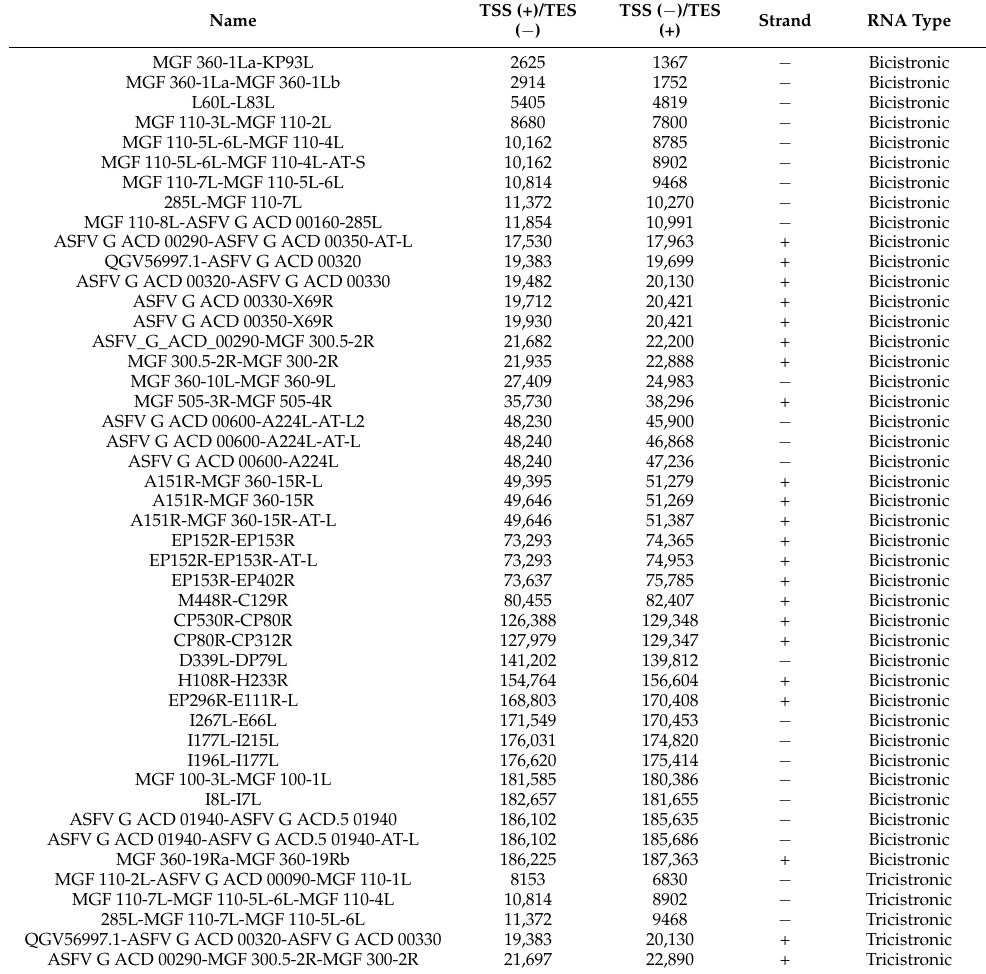
Table 4. List of polycistronic